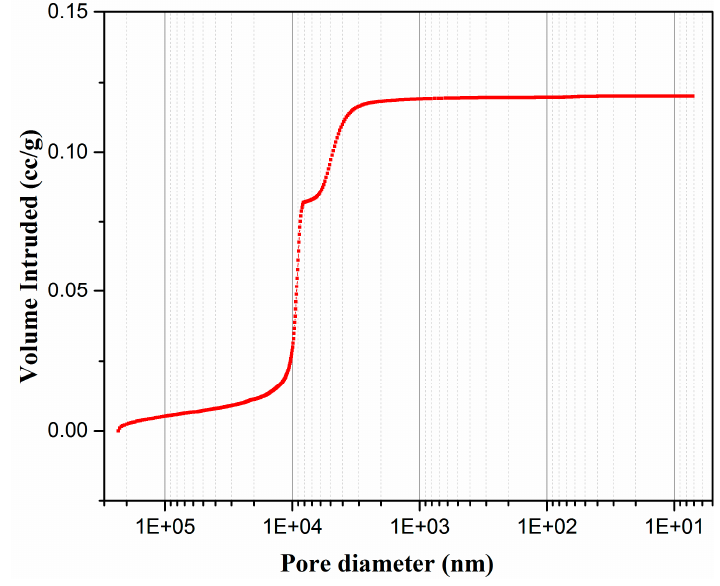
Figure 9. Mercury adsorption curve of talcum-fly ash support.